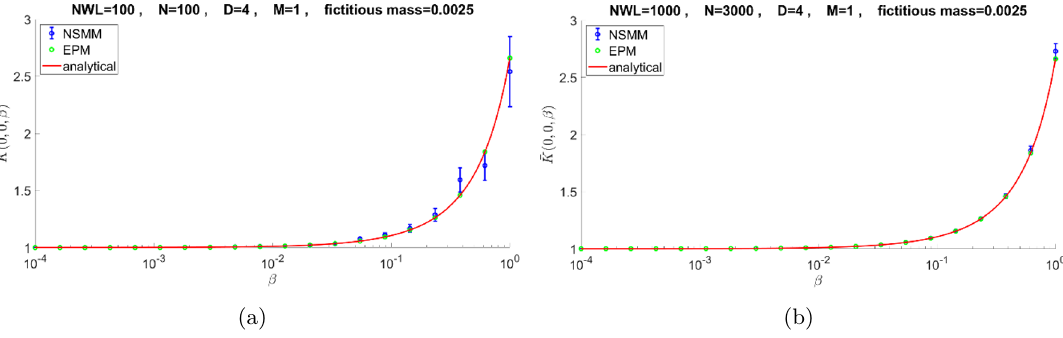
Figure 2 . Calculations of the heat kernel of a free scalar particle in a D =4 sphere with endpoints x = x 0 = 0 for various parameters ( N WL , N ) both using the effective potential method (green data) with known potential and using the non-linear sigma model method (blue data). The red curve is the analytical and perturbative computation for small β performed in